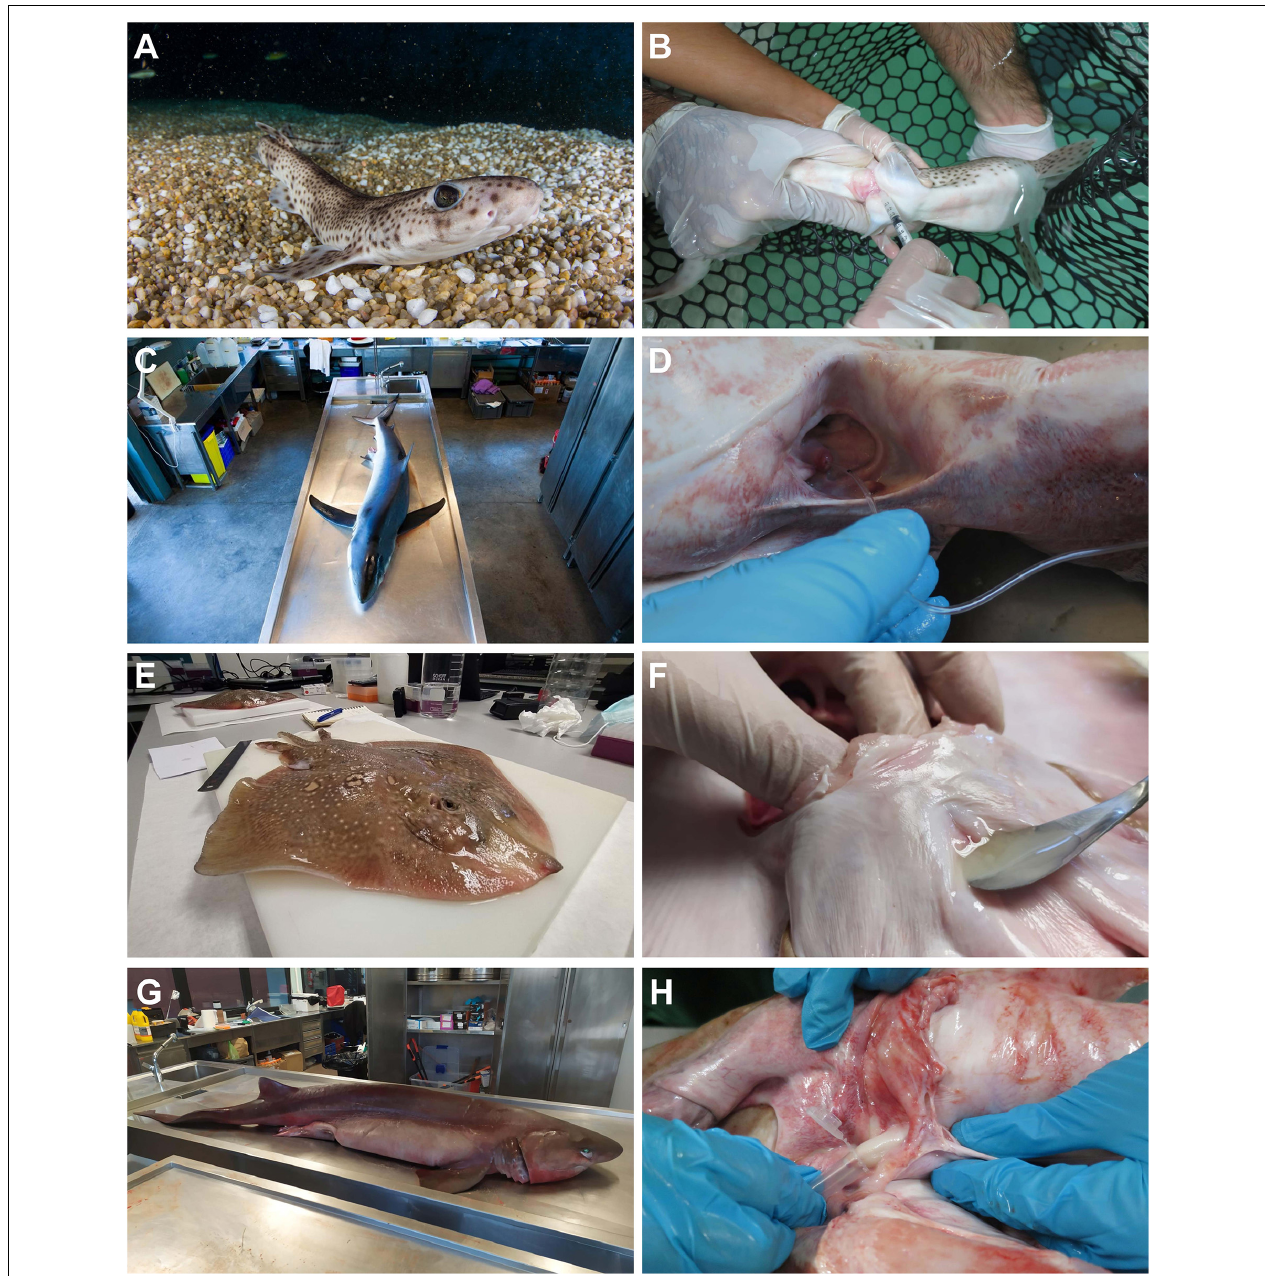
FIGURE 2 | Sperm extraction procedures. Sperm obtained from: (A,B) live animals ( Scyliorhinus canicula ) by abdominal massage. (C,D) Stranded animals ( Prionace glauca ) by cannulation through the urogenital papilla. (E,F) Animals from commercial fisheries ( Raja radula ) by necropsy, and (G,H) animals obtained from by-catch ( Hexanchus griseus ) by